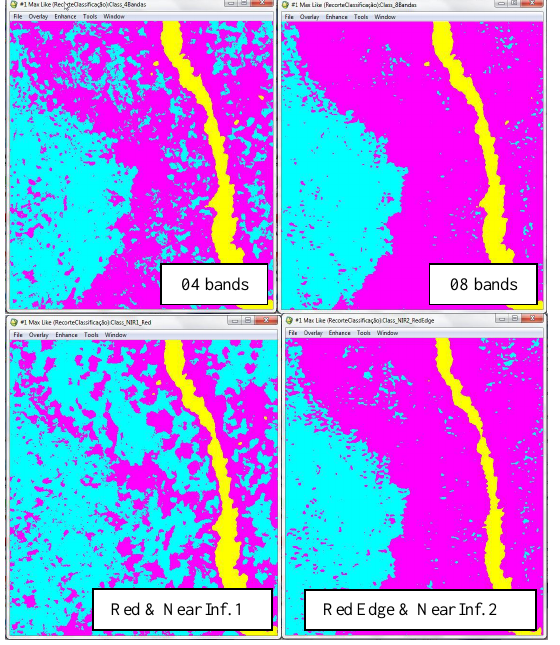
Figure 7: NDVI from the area under study. At Figure 7 one perceives that the classifications with the eight WorldView-II bands and with the Red Edge and Near Infrared 2 bands improve the discrimination of targets, if comparing to the use of only bands red, green, blue and infrared common at other high spatial resolution systems or only using the red and near infrared bands, considered at the conventional NDVI calculation.